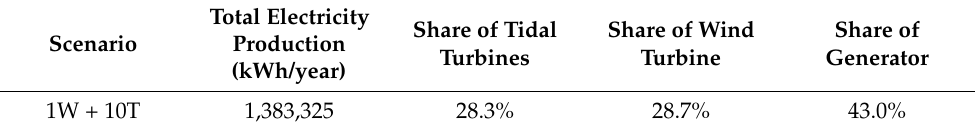
Figure 16. Monthly average output power for 1W + 10T. Table 7. Share of wind and tidal turbines in electricity production for 1W + 10T.